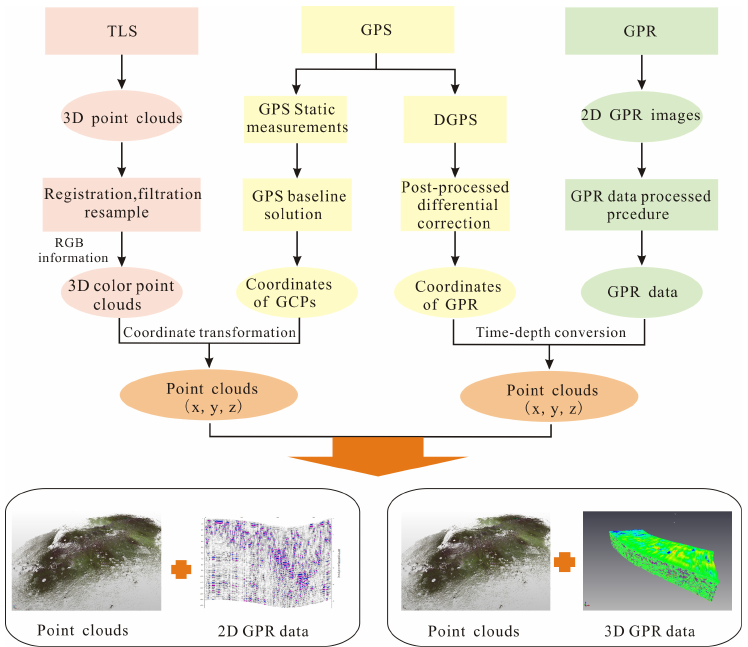
Figure 7. Data integration method of TLS and